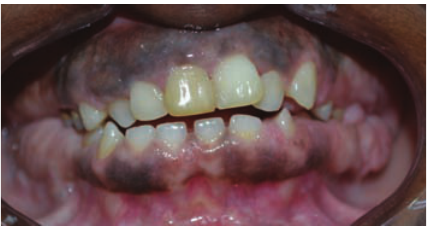
Figure4:Clinicalpictureof25-year-oldsisterwithgingivalenlarge- ment.